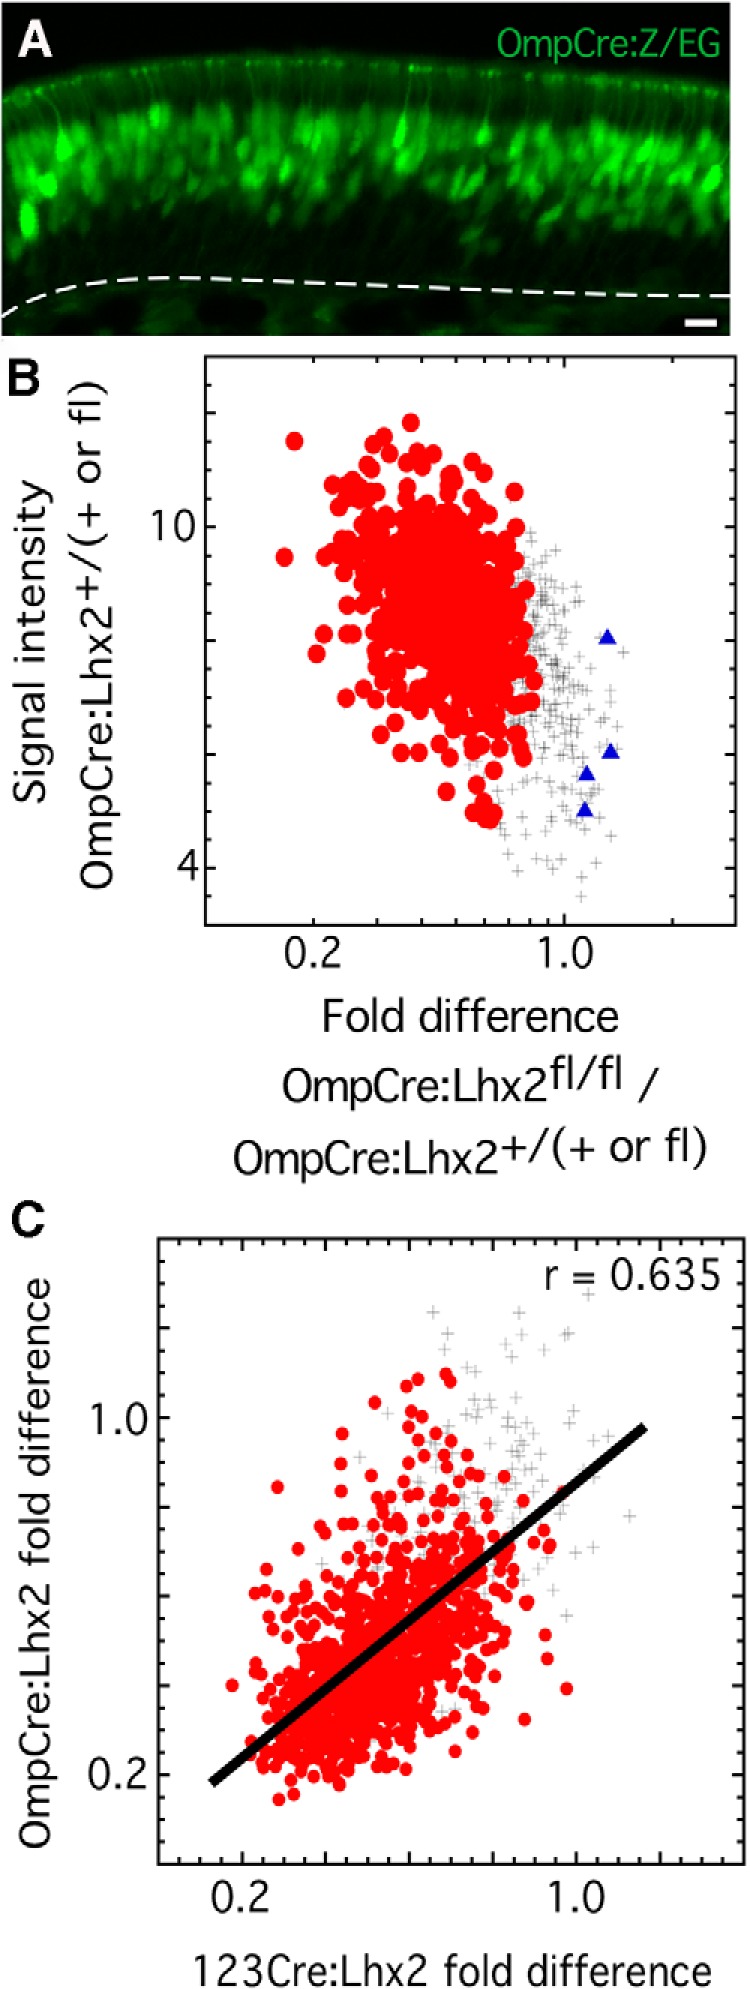
Deletion of Lhx2 in mature OSNs decreases the abundance of most OR mRNAs. A, In OmpCre:Z/EG mice, recombination-dependent GFP expression marks OSNs in the mature OSN layer. Dashed line, Location of the basal lamina separating the olfactory epithelium and lamina propria. Scale bar, 20 µm. B, In OmpCre:Lhx2fl/fl mice, the abundance of 765 OR mRNAs is decreased relative to littermate controls (p < 0.01; n = 4; FDR <1%). •, Significant decrease; +, no difference from littermate controls; ▴, increased abundance. C, Deletion of Lhx2 in immature OSNs (123Cre:Lhx2) and mature OSNs (OmpCre:Lhx2) produced similar effects on the abundance of most OR mRNAs relative to littermate controls. Line, Pearson linear correlation fit; •, significant decrease in at least one of the two datasets; +, no decrease compared with littermate controls.